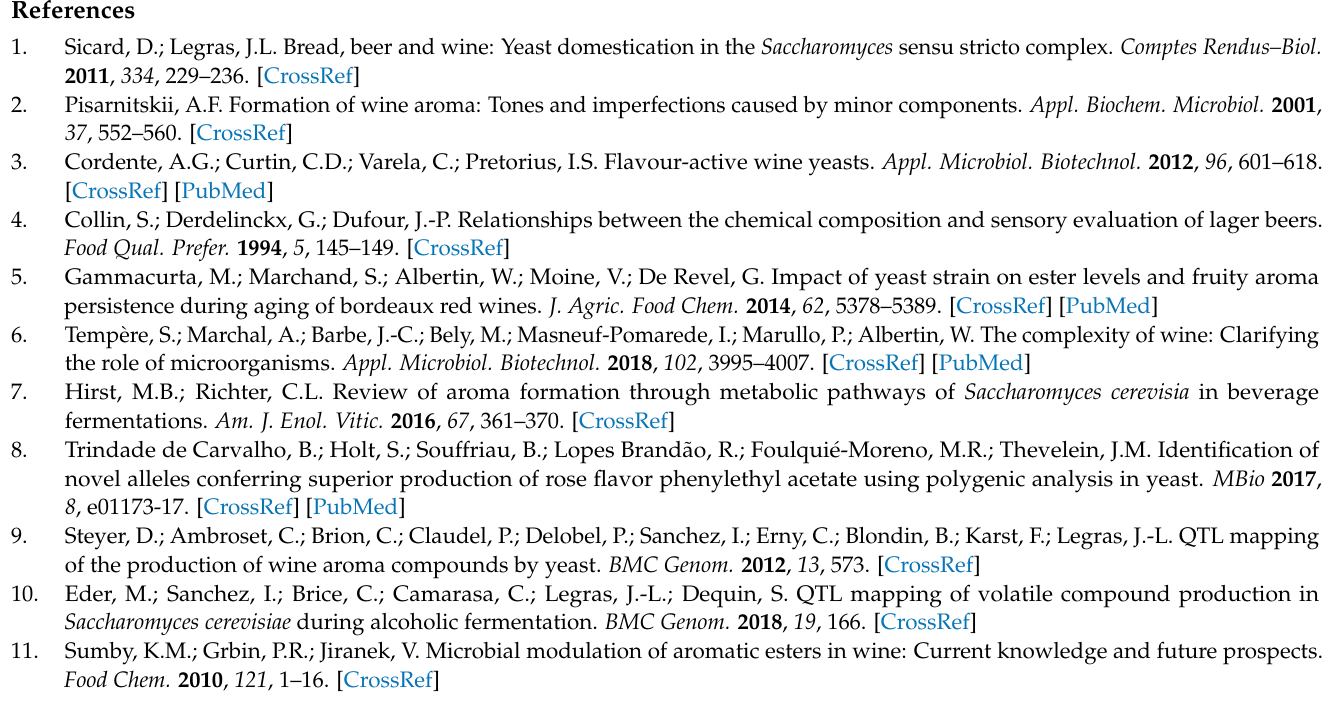
and Tempranillo grapes, Table S3: Anova table, Table S4: Description of the various aromatic reconstitutions carried out and results obtained after sensory (triangular tests) and statistical analysis, Table S5: Expression fold change of DEGs identified. Table S6: Primers used, Table S7: Monitored ions for quantification of the different compounds. Figure S1: Production level of EASHA of the strains Fx10 (wt), Fx10- ∆ AE ( ∆ atf1 , ∆ atf2 , ∆ eeb1 , ∆ eht1 ) and Fx10- ∆ ME ( ∆ mgl2 , ∆ eeb1 , ∆ eht1 ), Figure S2: Relative contribution of mono-acyl glycerol lipase activities (Mgl2p, Yju3p) on esters and their respective metabolic precursors measured in Merlot and Tempranillo grape musts, Figure S3 (File S9): Gene ontology analysis of cellular processes affected in the Fx10- ∆ AE